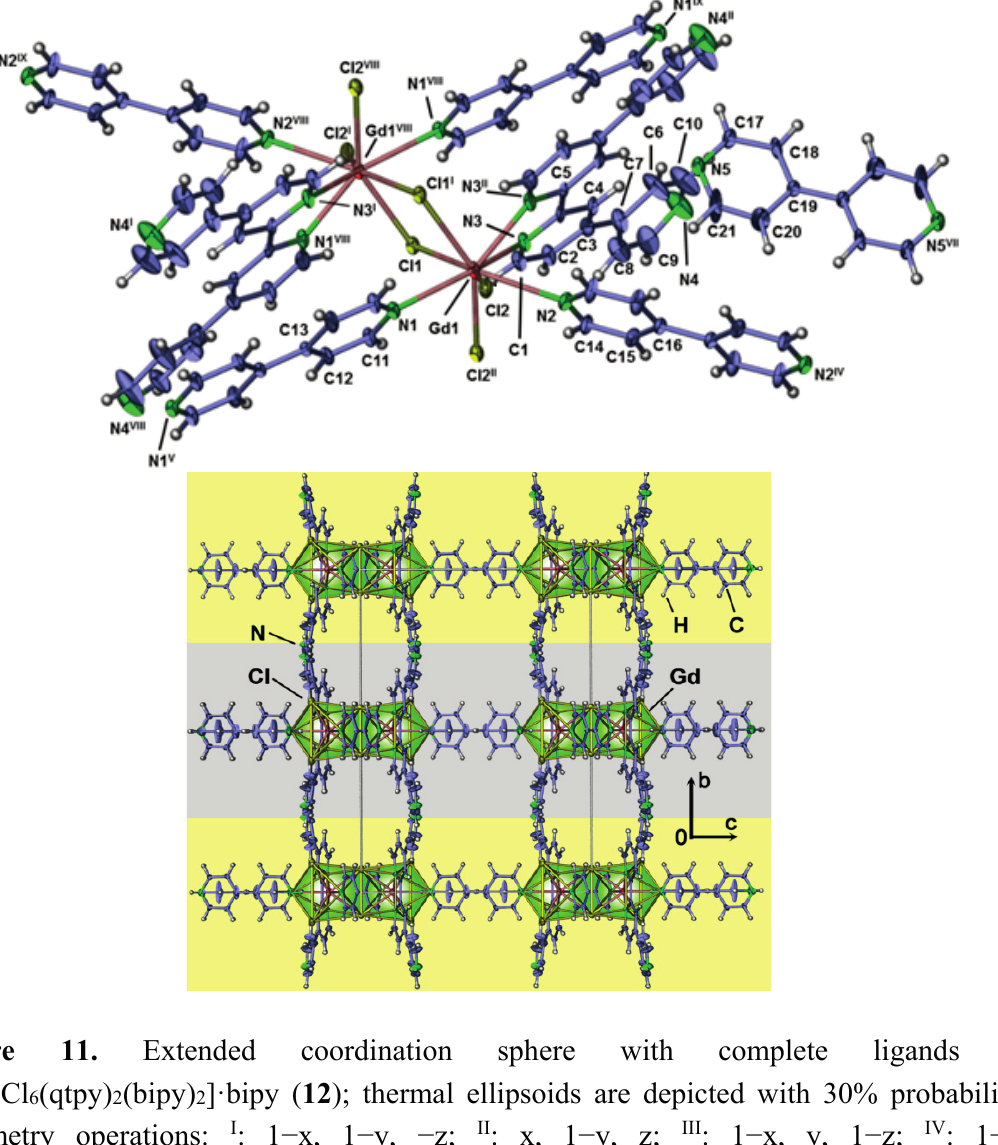
Figure 11. Extended coordination sphere with complete ligands of 2 ∞ [Gd 2 Cl 6 (qtpy) 2 (bipy) 2 ]·bipy ( 12 ); thermal ellipsoids are depicted with 30% probability. Symmetry operations: I : 1 − x, 1 − y, − z; II : x, 1 − y, z; III : 1 − x, y, 1 − z; IV : 1 − x, 1 − y, 1 − z; V : 2 − x, y, − z; VI : 2 − x, 1 − y, − z; VII : x, y, 1 − z; VIII : 1 − x, y, − z; IX : x − 1, 1 − y, z; ( top ). View along the a -axis of the single-crystal structure of 2 ∞ [Gd 2 Cl 6 (qtpy) 2 (bipy) 2 ]·bipy with parallel sheets marked in yellow and grey ( bottom